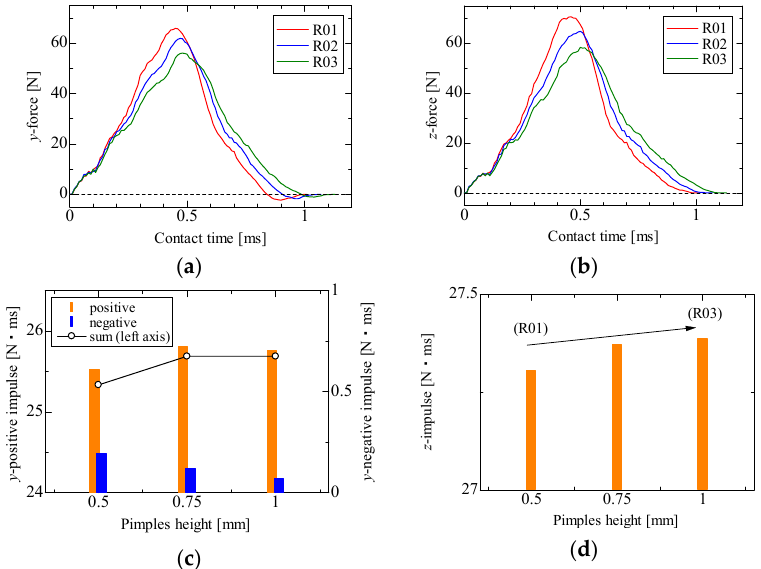
Figure 4. These figures show the simulation results of the contact force and impulse during impact with different pimple heights: ( a ) the 𝑦 component force; ( b ) the 𝑧 component force; ( c ) the 𝑦 component impulse; ( d ) the 𝑧 component